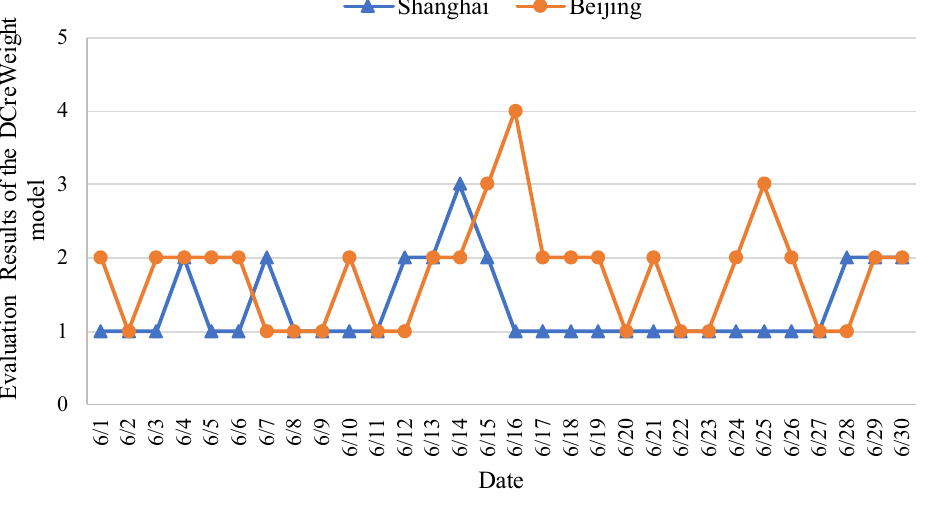
Figure 7. Evaluation Results of the DCreWeight model.